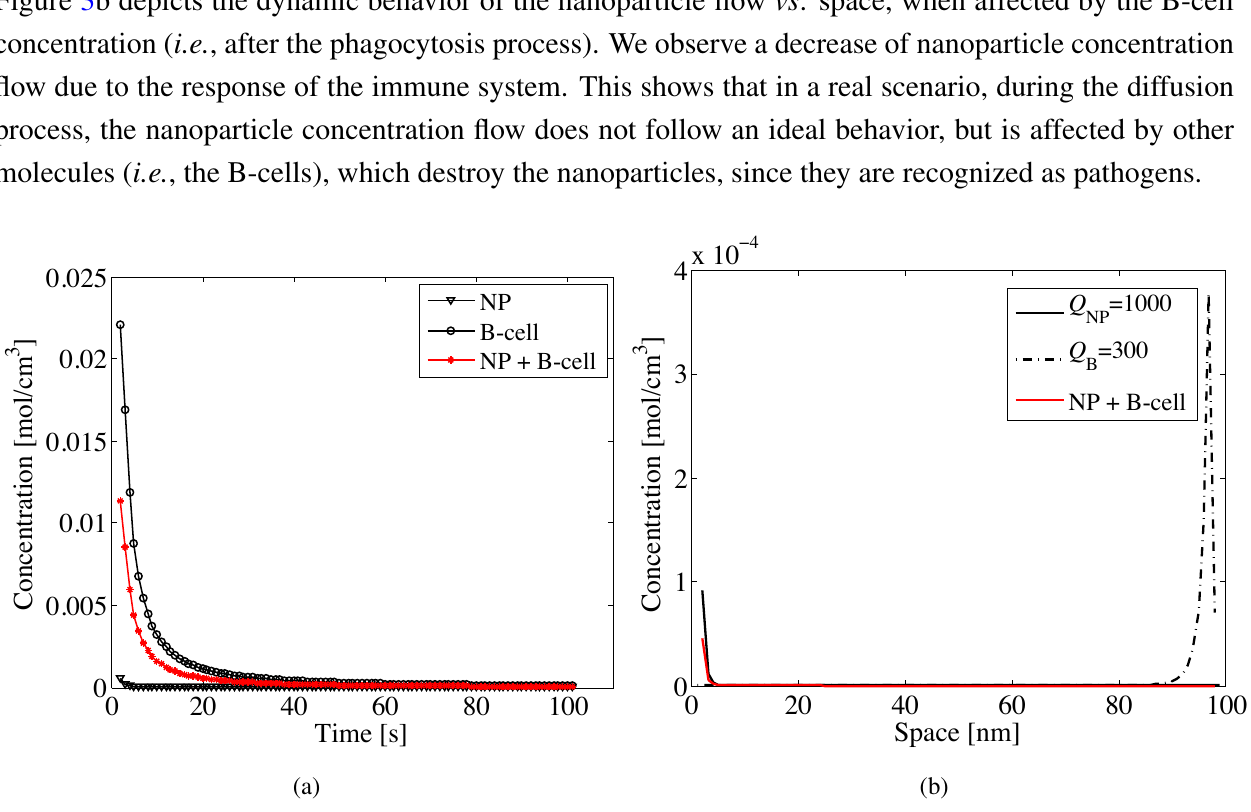
= 1000 (mol) and Q = 300 NP B